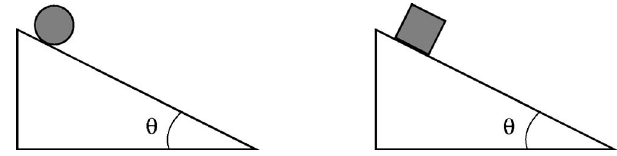
FIG. 3. An inclined plane with a sphere or a cube released from